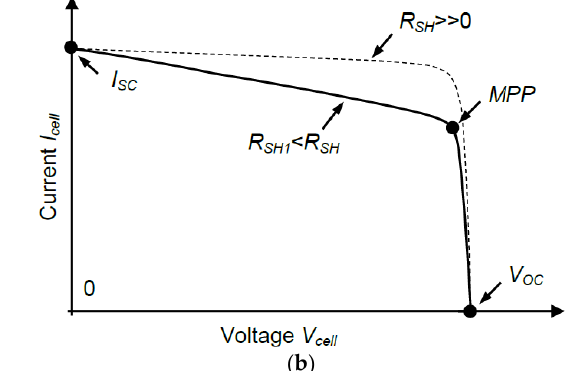
Figure 2. Typical I – V characteristics of a PV cell with marked characteristic points.